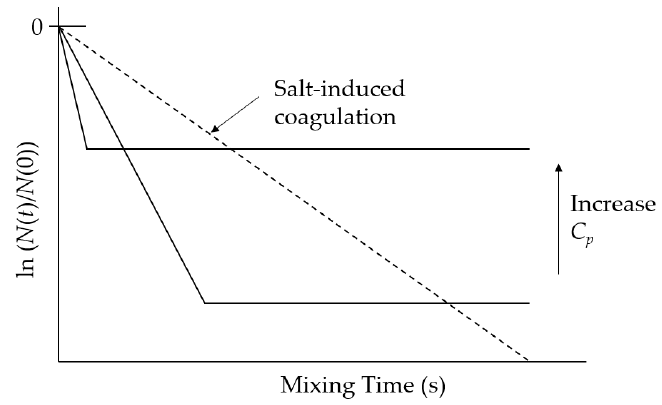
Figure 2. Schematic diagram of progressive polymer-induced flocculation.